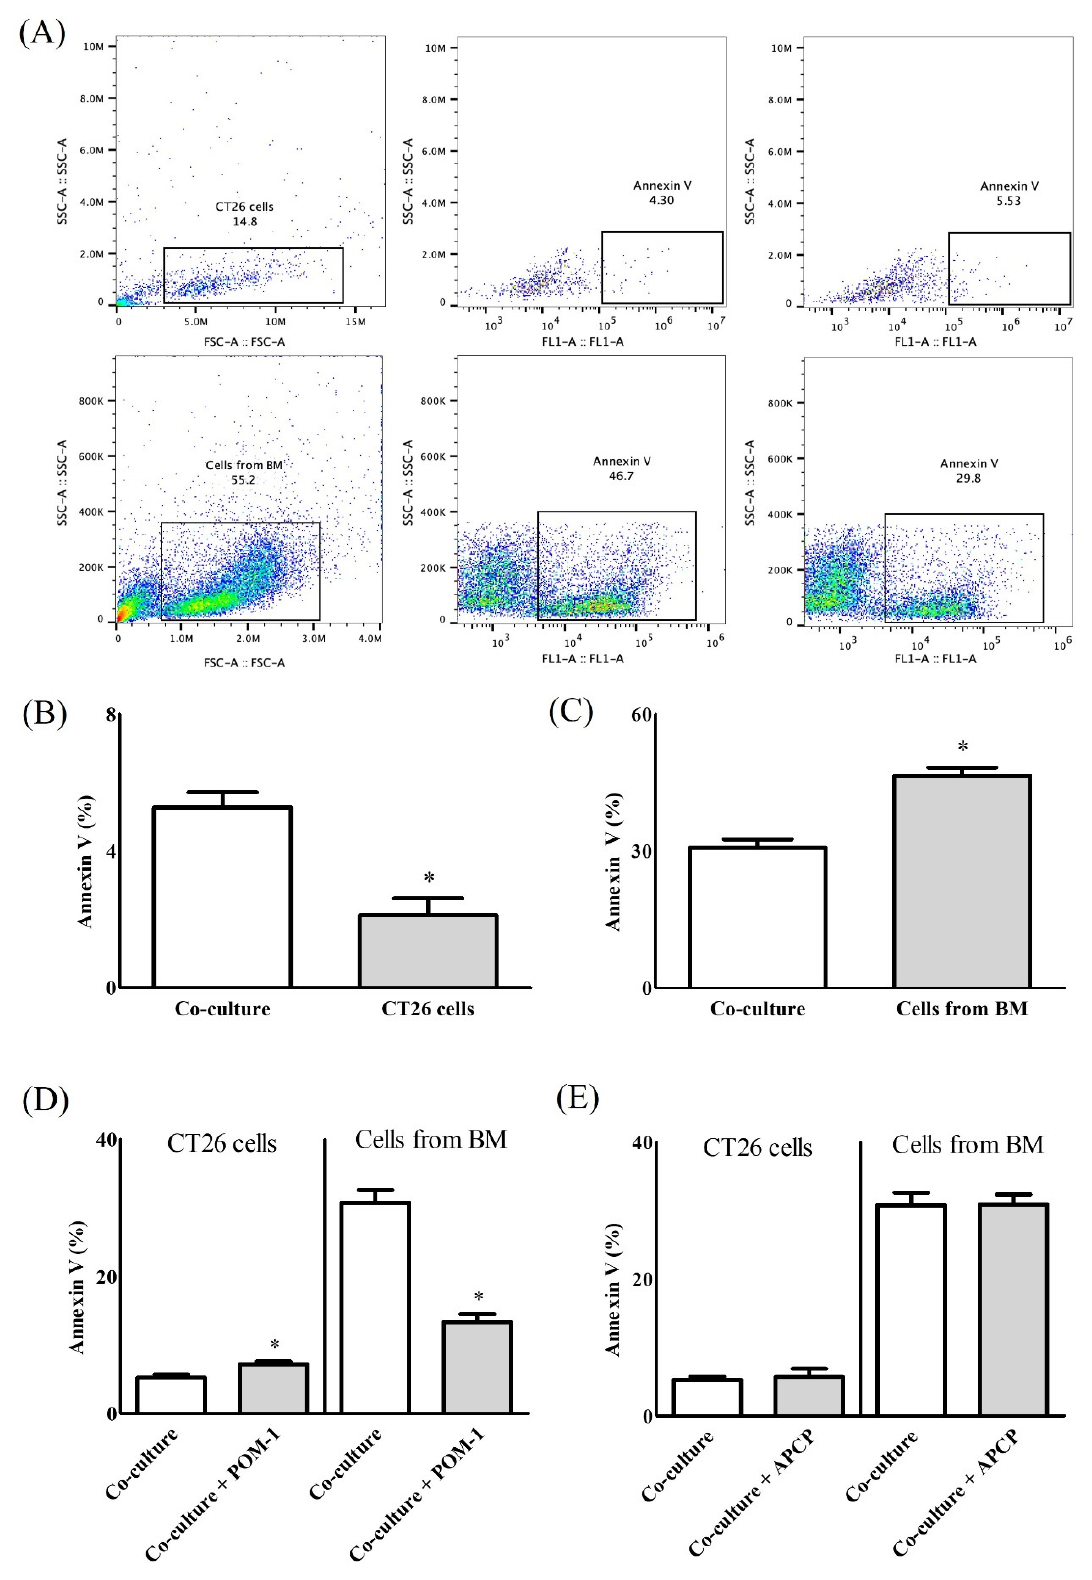
Figure 1. Apoptosis of co-culture of CT26 cells and the cells from bone marrow (BM). ( A ) Representative image of gating strategy for flow cytometry, ( B ) Apoptosis of CT26 cells, ( C ) Apoptosis of the cells from BM, ( D ) Apoptosis at co-culture with polyoxotungstate (POM-1) as an inhibitor of cluster differentiation (CD)39, and ( E ) Apoptosis at co-culture with adenosine 5’-( α , β -methylene)diphosphate (APCP) as an inhibitor of CD73. *: p < 0.05.